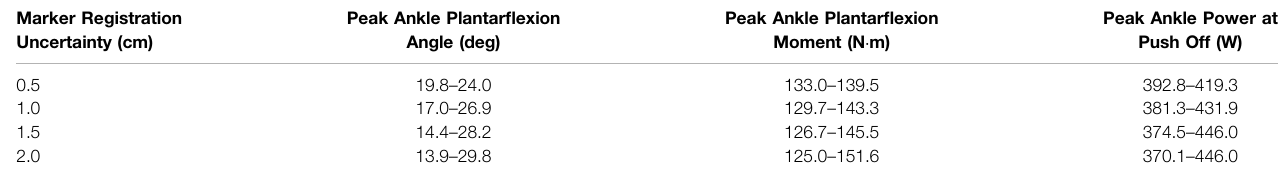
TABLE 3 | Uncertainty in peak ankle angle, moment, and power during healthy walking for different levels of marker registration uncertainty. Results were obtained by generating N = 100 equally probable models at each level of uncertainty. Marker Registration Uncertainty